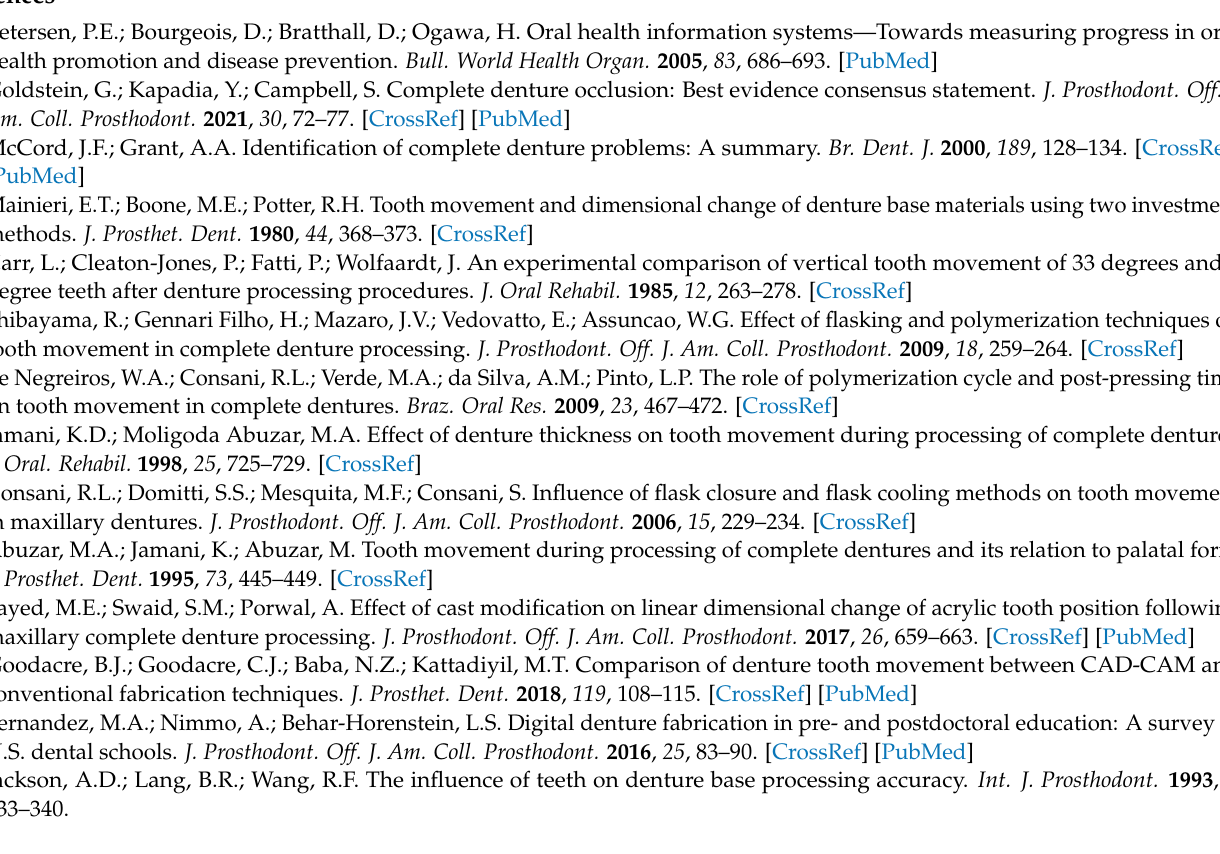
Table S2: Shapiro Wilk Normality test used to check the normality of data after absolute value of differences was taken into